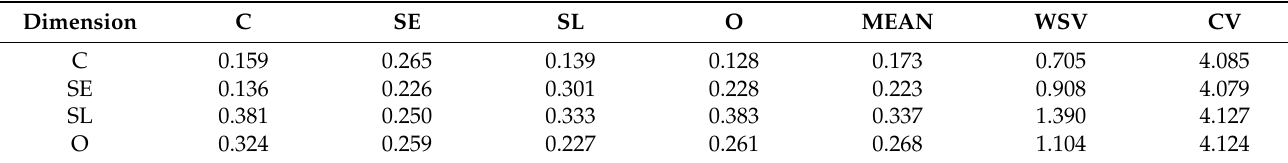
Table 9. The normalized comparison matrix of the AHP-SF